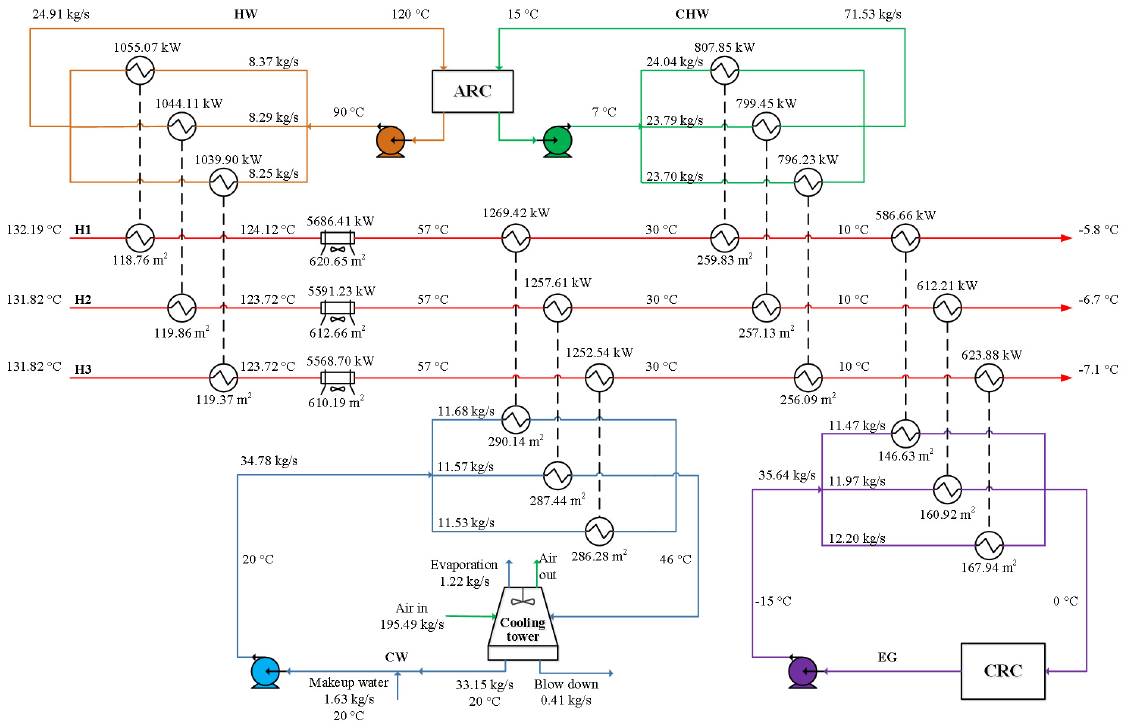
Figure 8. The optimal design of the cascade cooling system for hot streams.